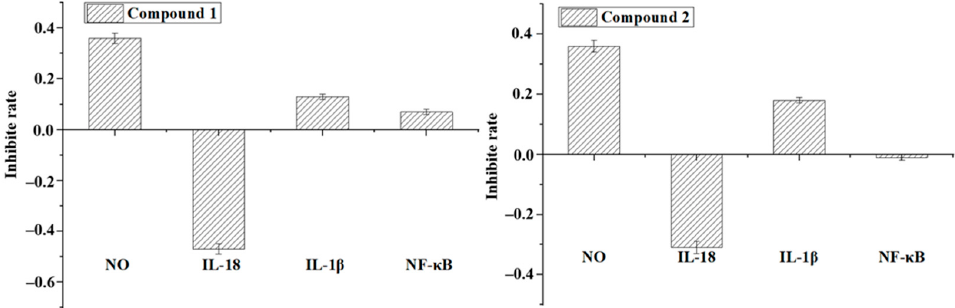
Figure 8. Chemical structures of six diterpenoids obtained from CNE-p.